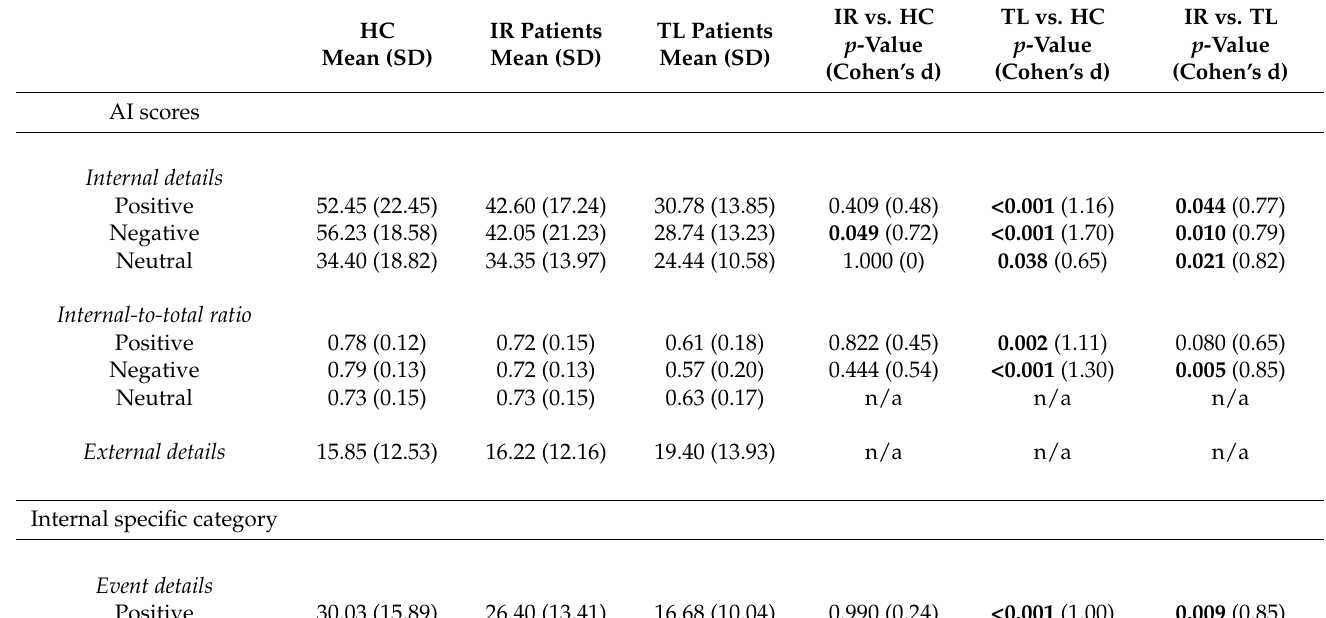
Table 6. AI results after specific